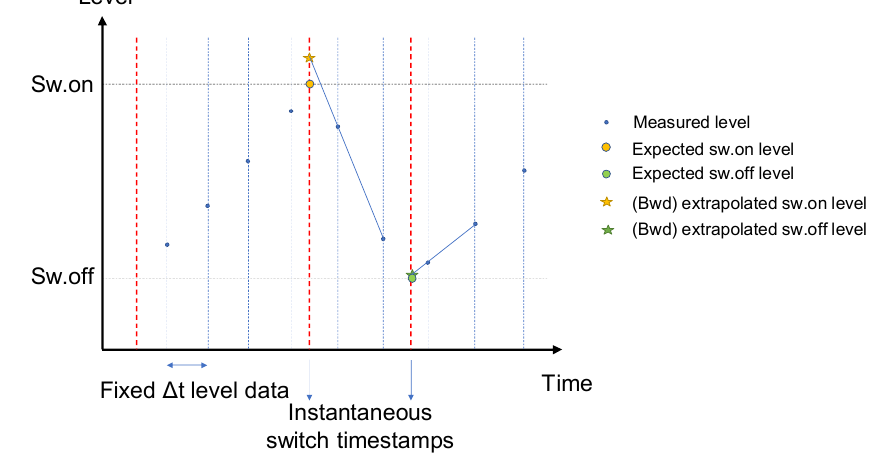
Figure A3. Estimation of switch levels by backward extrapolation.